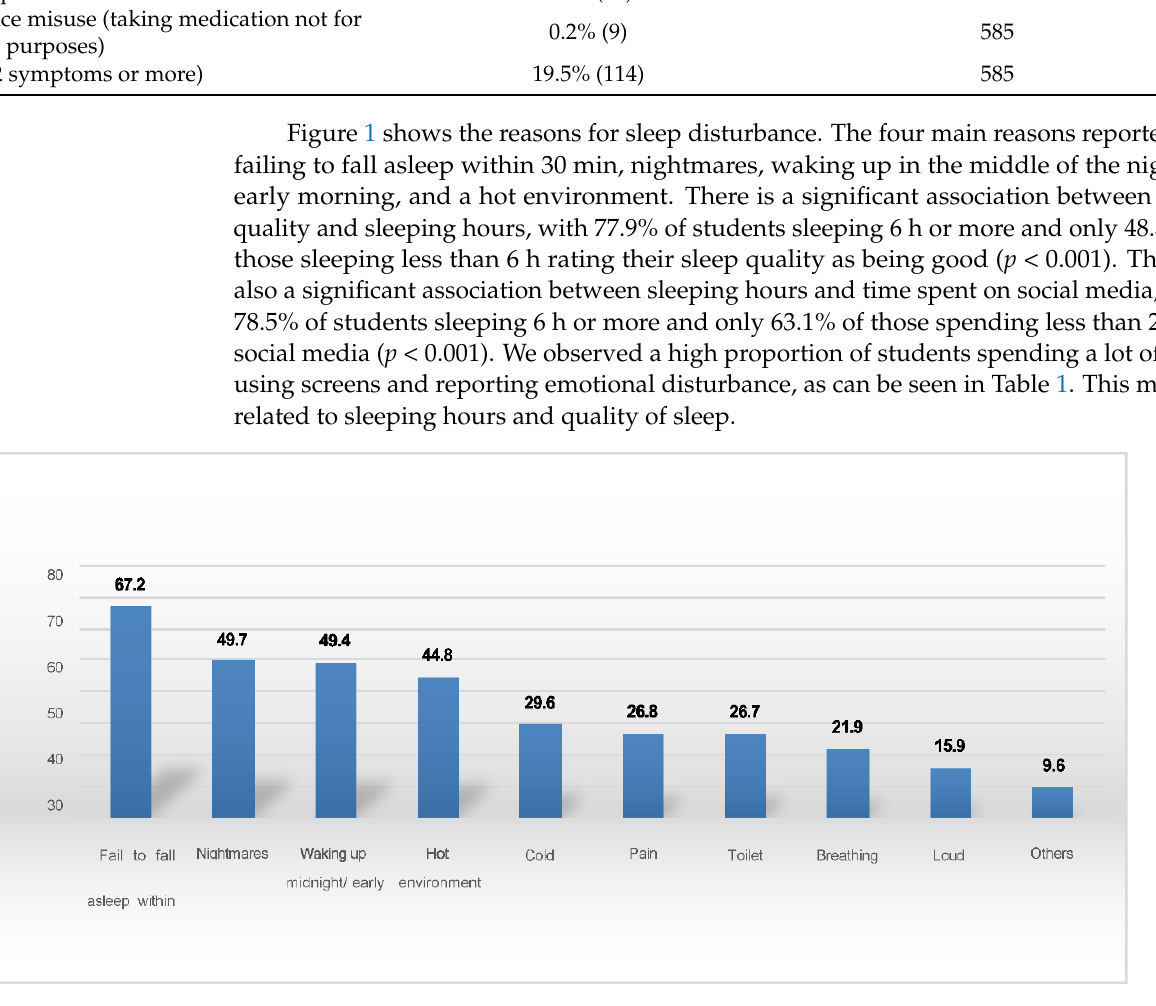
Figure 1. Reasons for sleep disturbances.